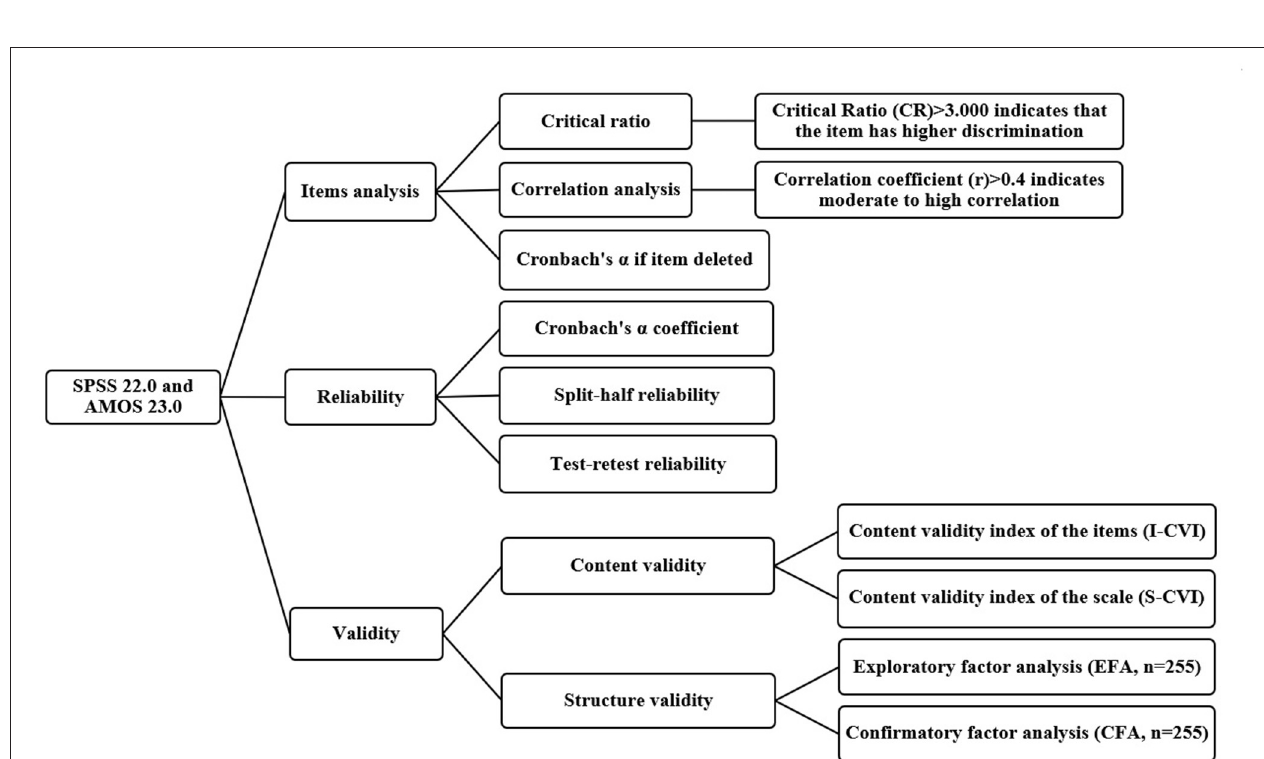
FIGURE 2 | The data analysis procedure for Chinese version of the